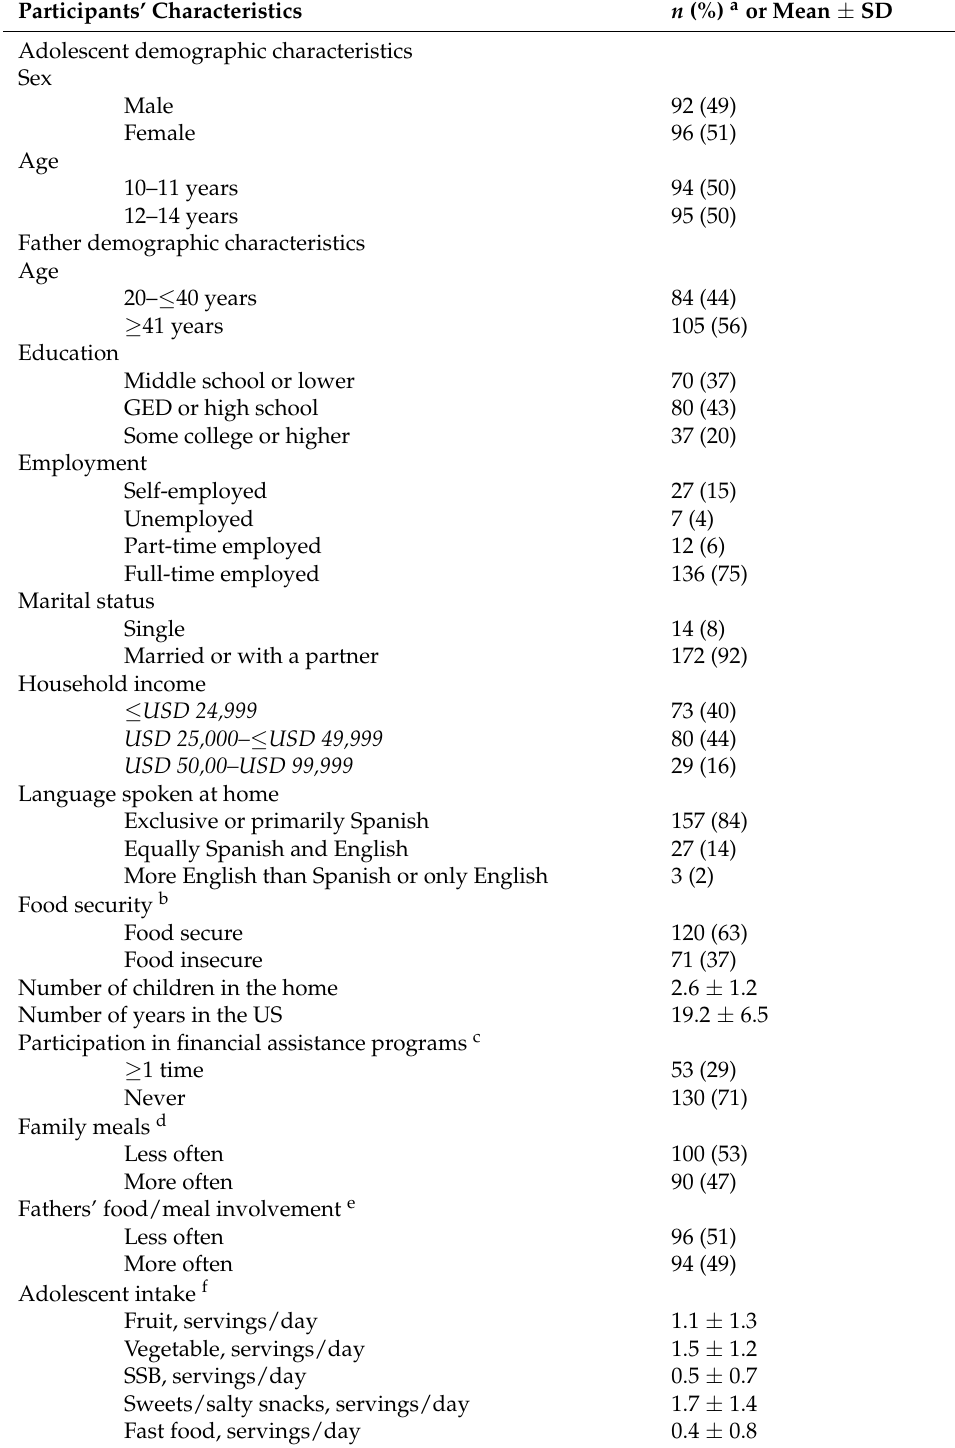
Table 1. Adolescent/father dyad sociodemographic characteristics and adolescent perceptions of family meals, fathers’ food/meal involvement, and adolescent dietary intake ( n = 191). Participants’